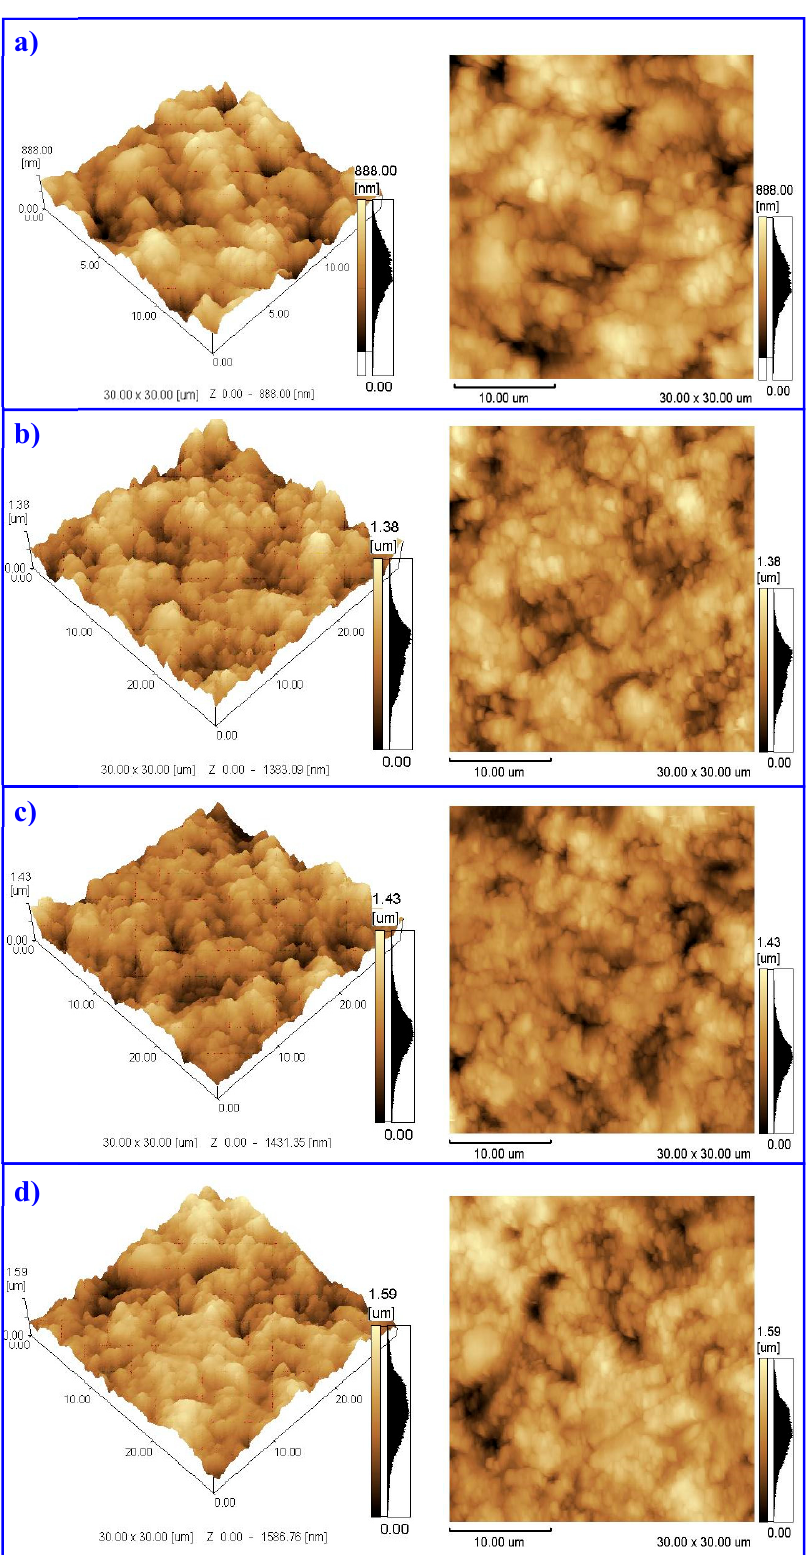
Figure 2. Atomic force microscope images of surface topography. ( a ) uncoated sample; ( b ) AlCrN/Si 3 N 4 physical vapor deposition (PVD) nanocomposite coating; ( c ) AlTiN/Si 3 N 4 PVD nanocomposite coating and ( d ) AlCrN PVD Coating.